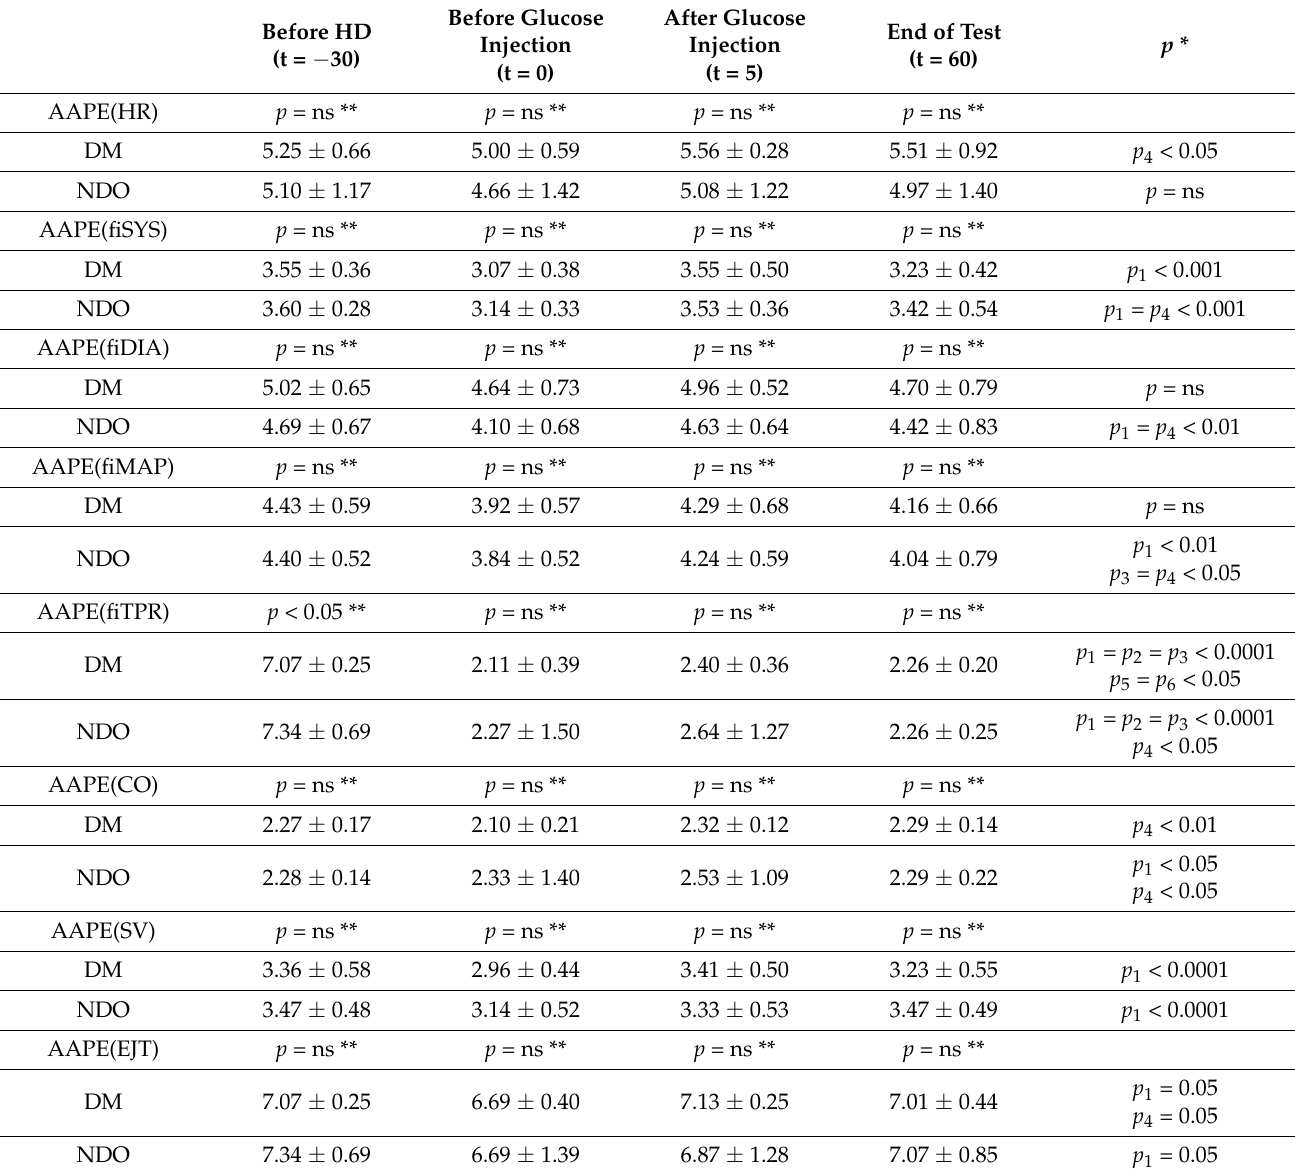
Table 1. Amplitude aware permutation entropy for different variables compared between groups at different time